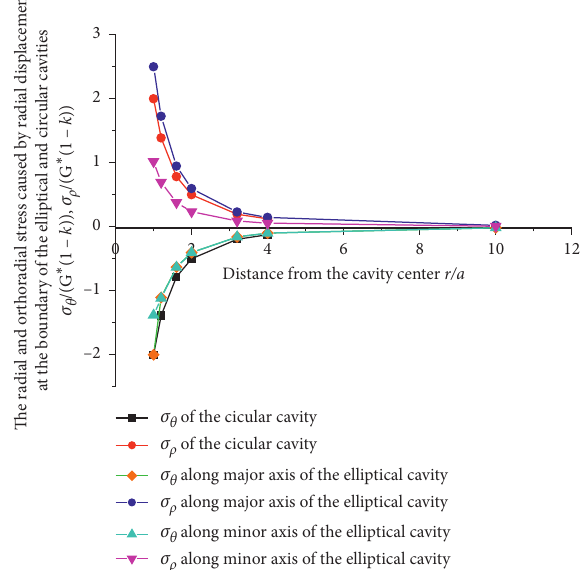
Figure 6: Distribution of the stress of the soil elements due to the radial displacement at the boundaries of the